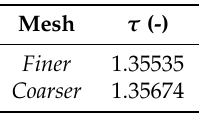
Table 1. Example of tortuosity sensitivity to mesh for the FCC.